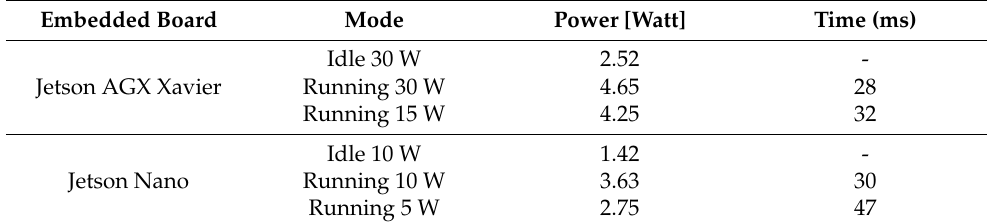
Table 7. Comparison of power consumption and inference time between Xavier and Nano.